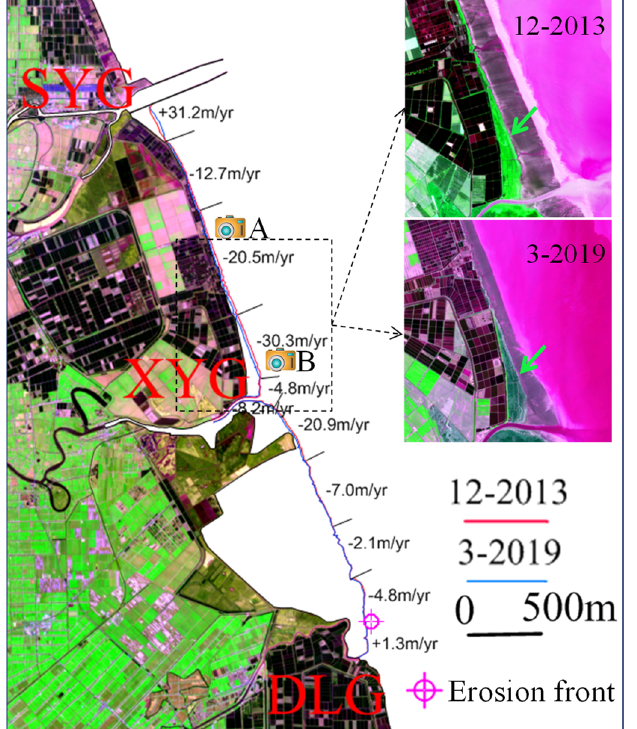
Figure 3. Downdrift shoreline evolution from December 2013 to March 2019. “SYG” denotes the Sheyang port, “XYG” denotes Xinyanggang, and “DLG” denotes Doulonggang. The inserted pseudocolor satellite images illustrate the variation in the salt marsh vegetation cover (green arrows) on the respective date.